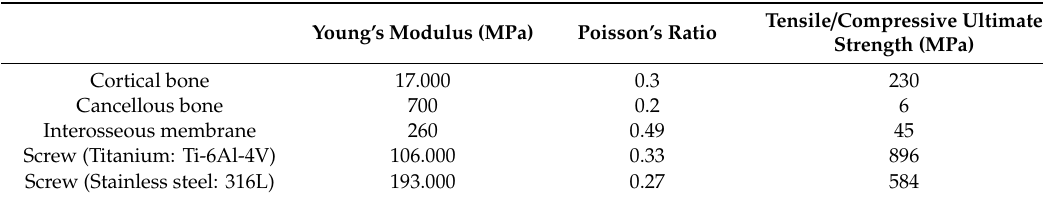
Table 2. Properties of various materials.